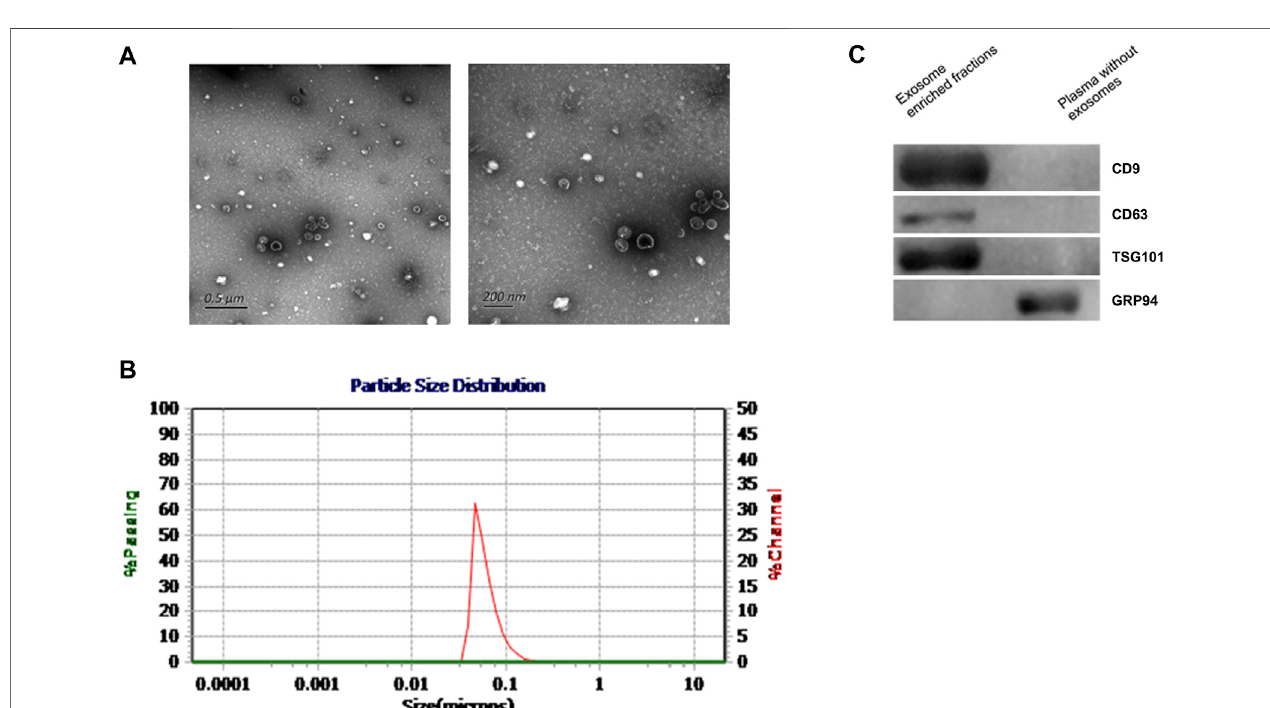
FIGURE 1 | Characteristics of plasma exosomes from participants. (A) . TEM images showing that the exosomes were bilayer vesicles (left image: wide fi eld containing multiple exosomes; right: close-up image of a single exosome). (B) . NTA results showing that the diameter of the enriched plasma exosomes was approximately 30 – 150 nm. (C) . Western blot showing that CD9, CD63 and TSG101 were detected in the enriched exosome samples isolated from plasma, while the negative exosomal marker GRP94 was not detected in these